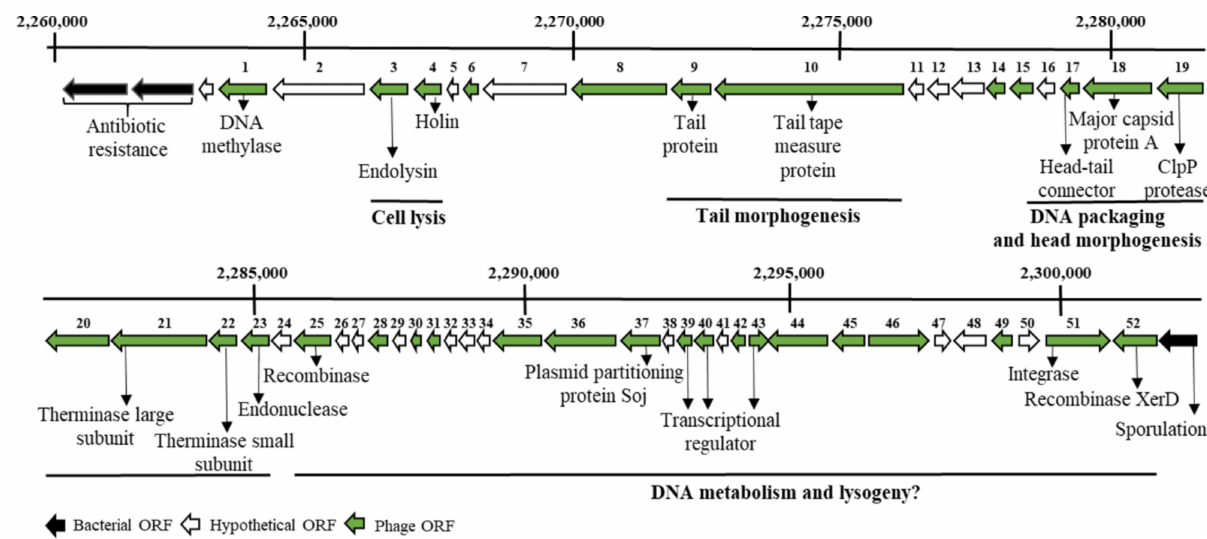
Figure 2. A fragment of C. botulinum E3 strain Alaska E43 genome map with predicted open reading frames (ORFs) within the prophage region. ORFs are depicted as arrows in the expected direction of transcription. Gray: bacterial ORF, green: phage ORF, white: hypothetical ORF. Putative functions were assigned based on conserved domain searches. The scheme was performed based on a graphical view of the complete genome sequence of C. botulinum E3 strain Alaska